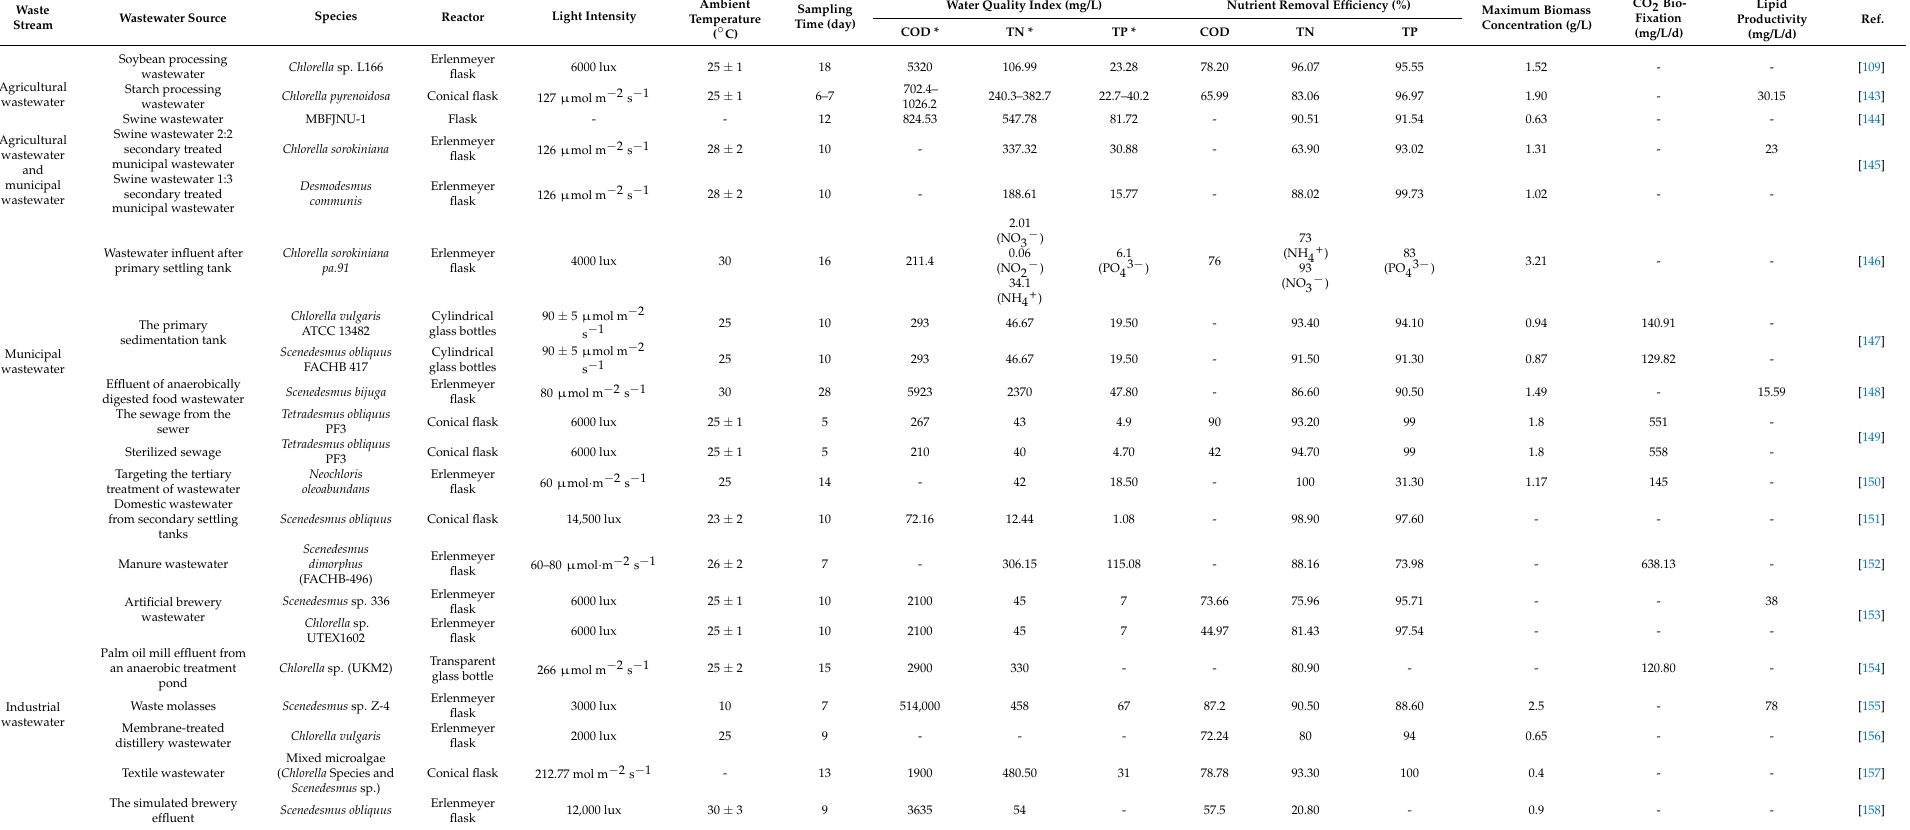
Table A2. Comparison of the removal efficiency of pollutants in different wastewater types by various